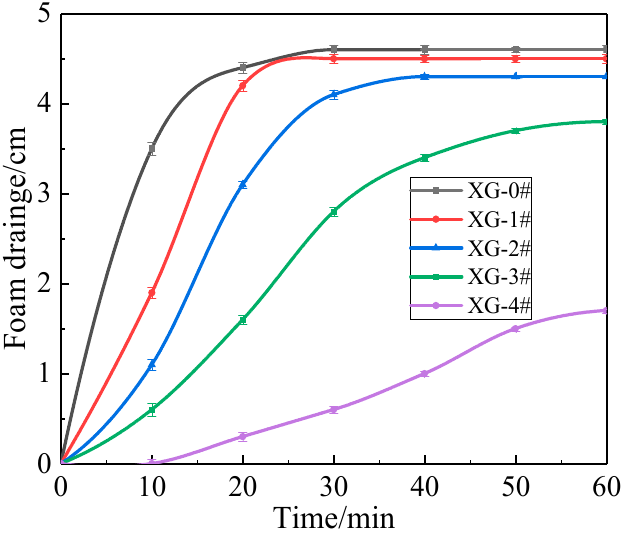
Figure 6. Variation in foam drainage height under 200 °C versus time.